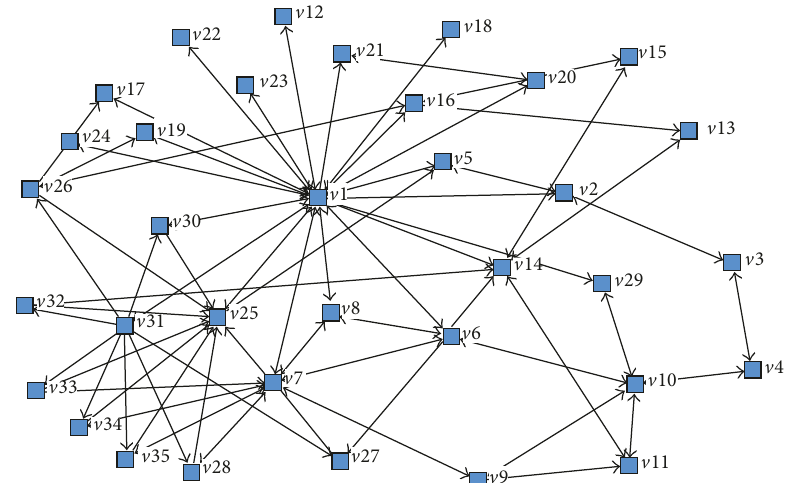
Figure 5: The holistic topological network of bogie system: every node V 𝑖 has property set (𝐴 𝑓 ( V 𝑖 ),𝐴 𝑡 ( V 𝑖 )) , and every edge 𝑒 𝑖𝑗 has property set (𝐵 𝑓 (𝑒 𝑖𝑗 ))